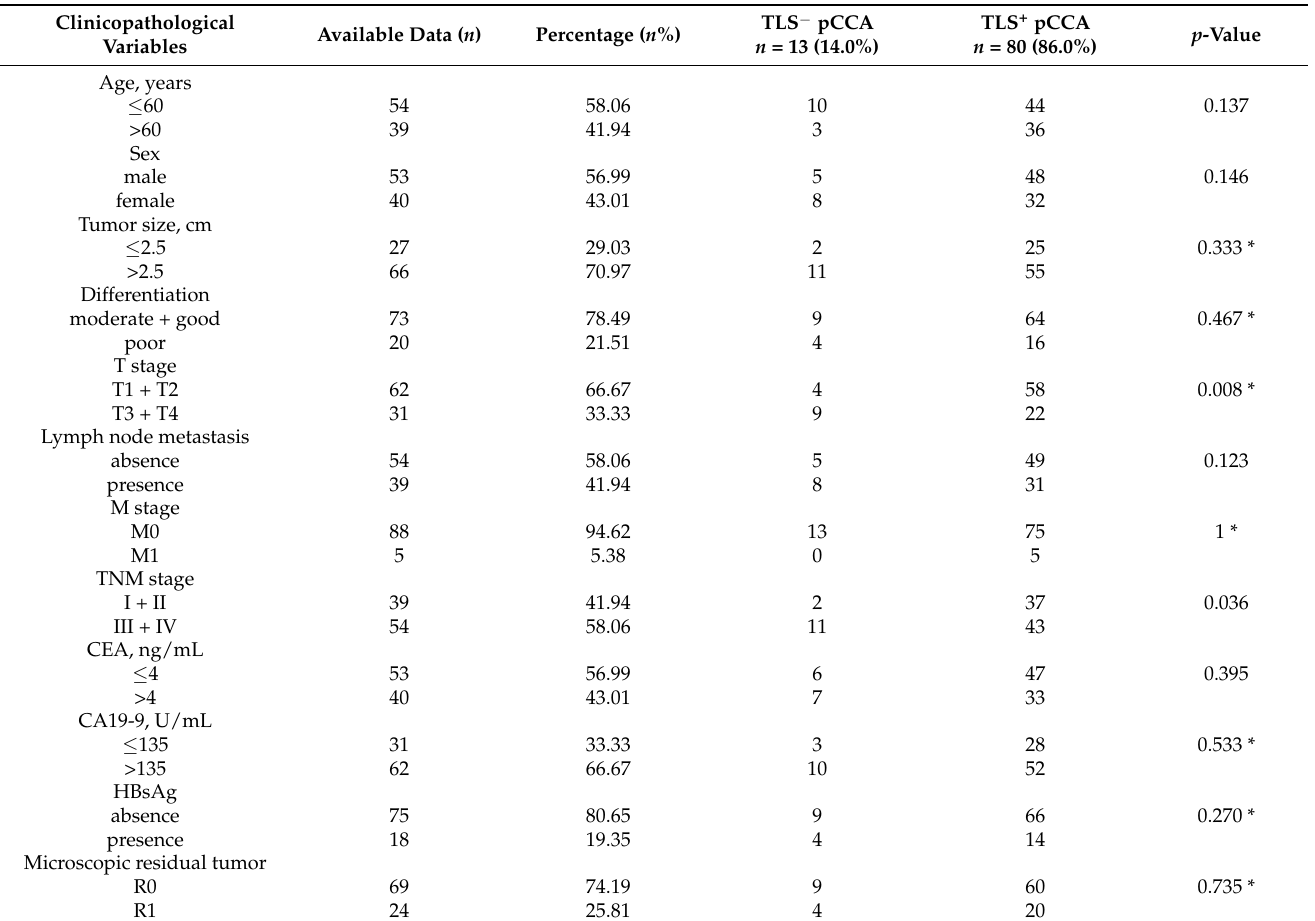
Table 1. Correlation analyses between intra-tumoral TLSs and the patients’ clinicopathological characteristics.